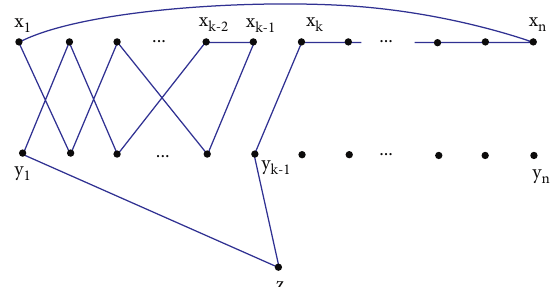
Figure 14: A cycle of length n + k in μ ( G ) if k is odd.